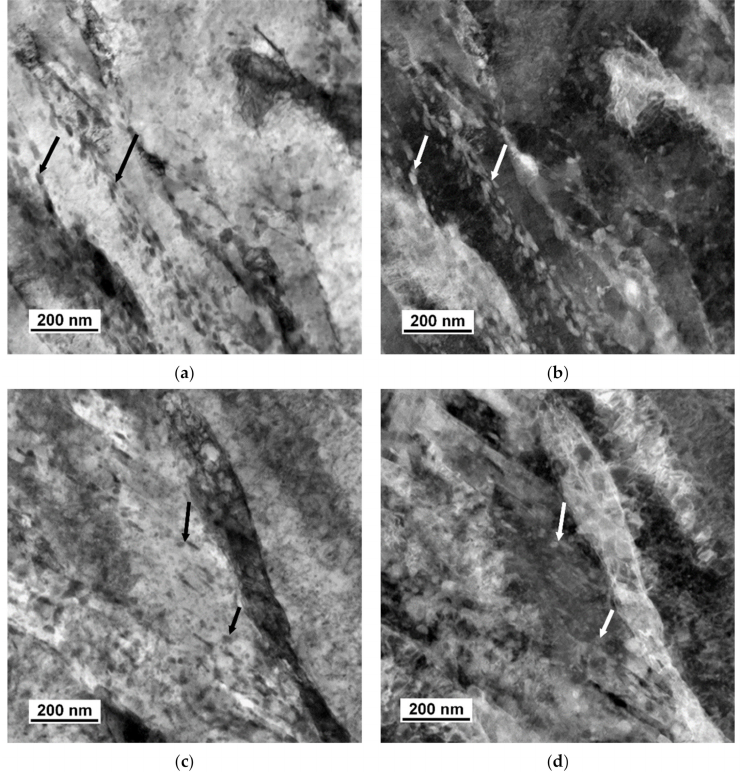
Figure 8. TEM micrograph showing cementite precipitates in martensite tempered at 500 ◦ C in 42SiCr steel ( a ) BF, ( b ) DF and in 42SiCr + Cu steel ( c ) BF, ( d )